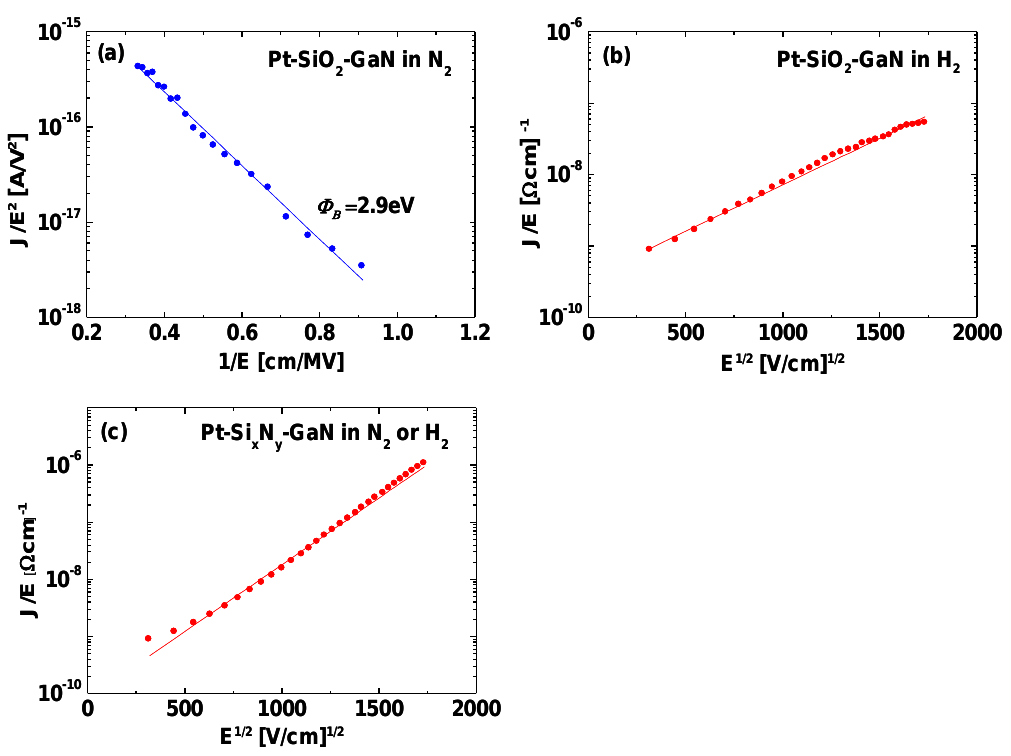
dielectric in a H 2 N dielectric in a N x y